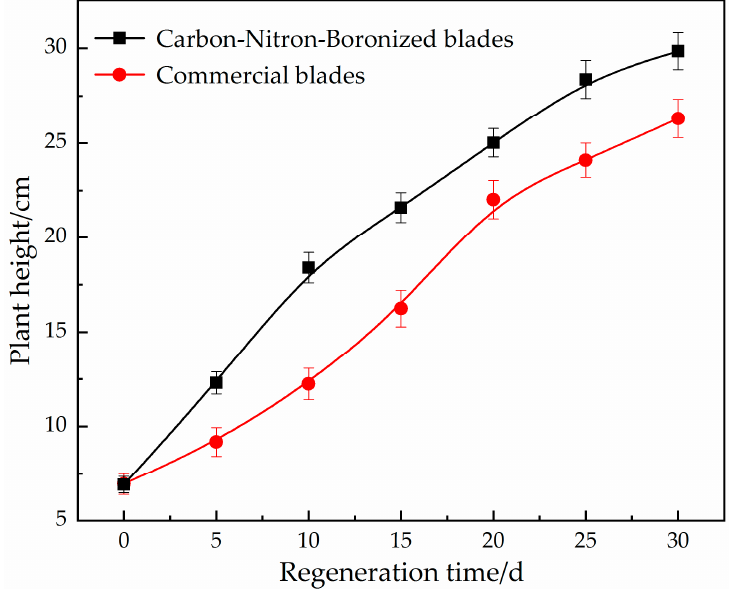
Figure 8. Changes of Alfalfa plant regeneration height after cutting with different blades.